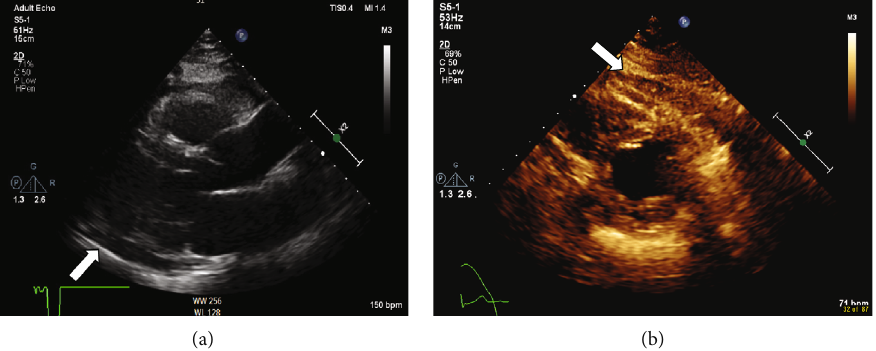
Figure 3: Transthoracic echocardiogram in the long parasternal axis view (a) and short axis view (b).